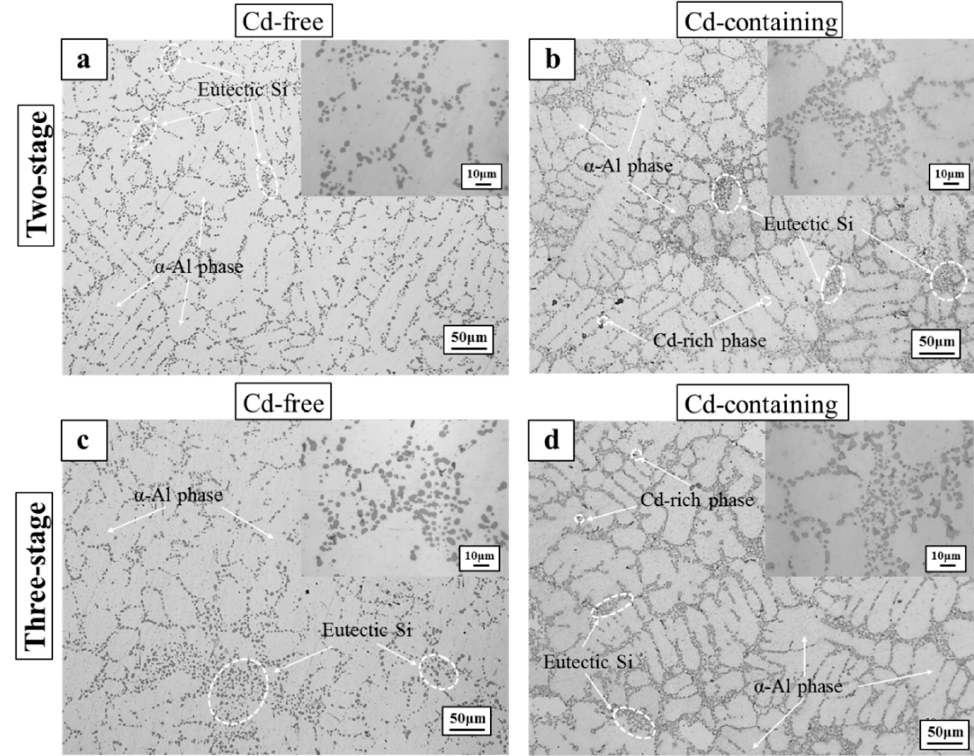
Figure 2. Microstructure and metallographic diagram of the alloys after solution treatment: ( a ) two-stage-Cd-free, ( b ) two-stage-Cd-containing, ( c ) three-stage-Cd-free, and ( d ) three-stage-Cd-containing.